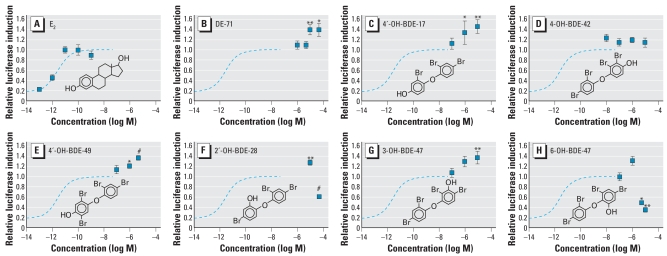
ERE-luciferase induction in BG1Luc4E2 cells after coteatment with E2. See “Material and Methods” for details. Squares indicate data for cotreatment with 10−11 M E2 and the specified chemical; data are normalized to the maximal effect of E2 (set at 1.0). Each curve is the mean of 3–5 independent dose–response studies, except for 2-OH-BDE28, 6-OH-BDE47, and 4-OH-BDE49 for which only 2 assays were performed. Error bars indicate SE. Modeled data for E2-only dose–response (blue dashed line) are shown in all charts for comparison.*p > 0.5; **p > 0.01; and #p > 0.001 compared with the maximal effect of E2 alone.